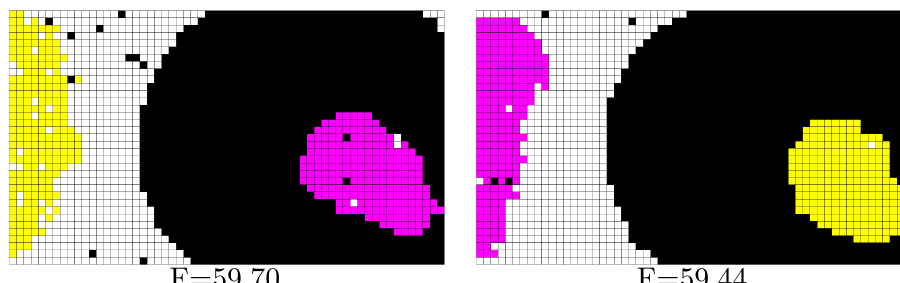
Figure 26. Optimized topologies after